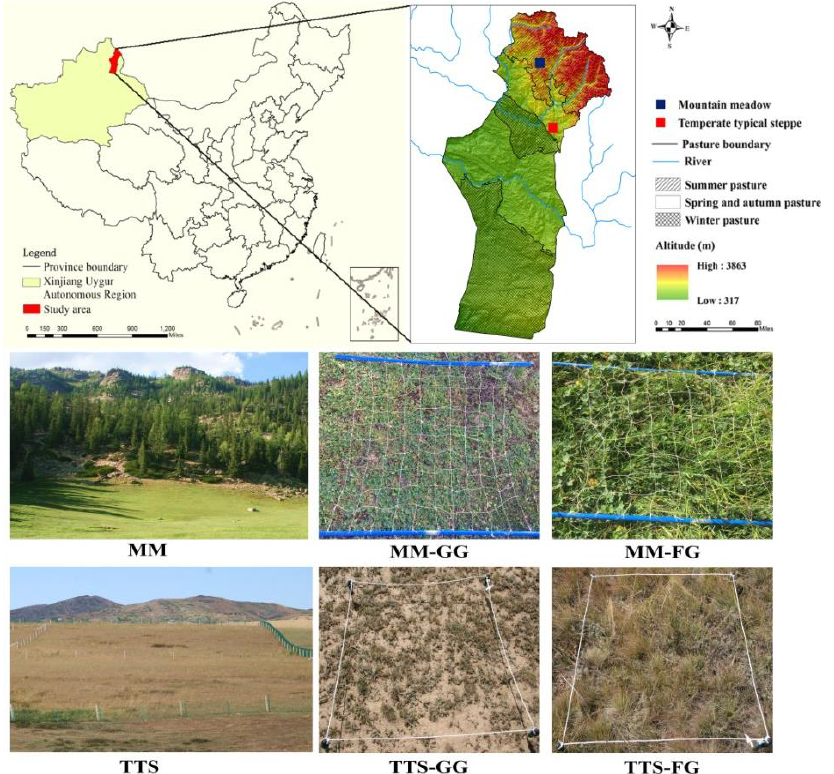
Figure 1. Location map of the study area and sample plots. MM: mountain meadow; TTS: temperate typical steppe; GG: grazed grassland; and FG: fenced grassland.